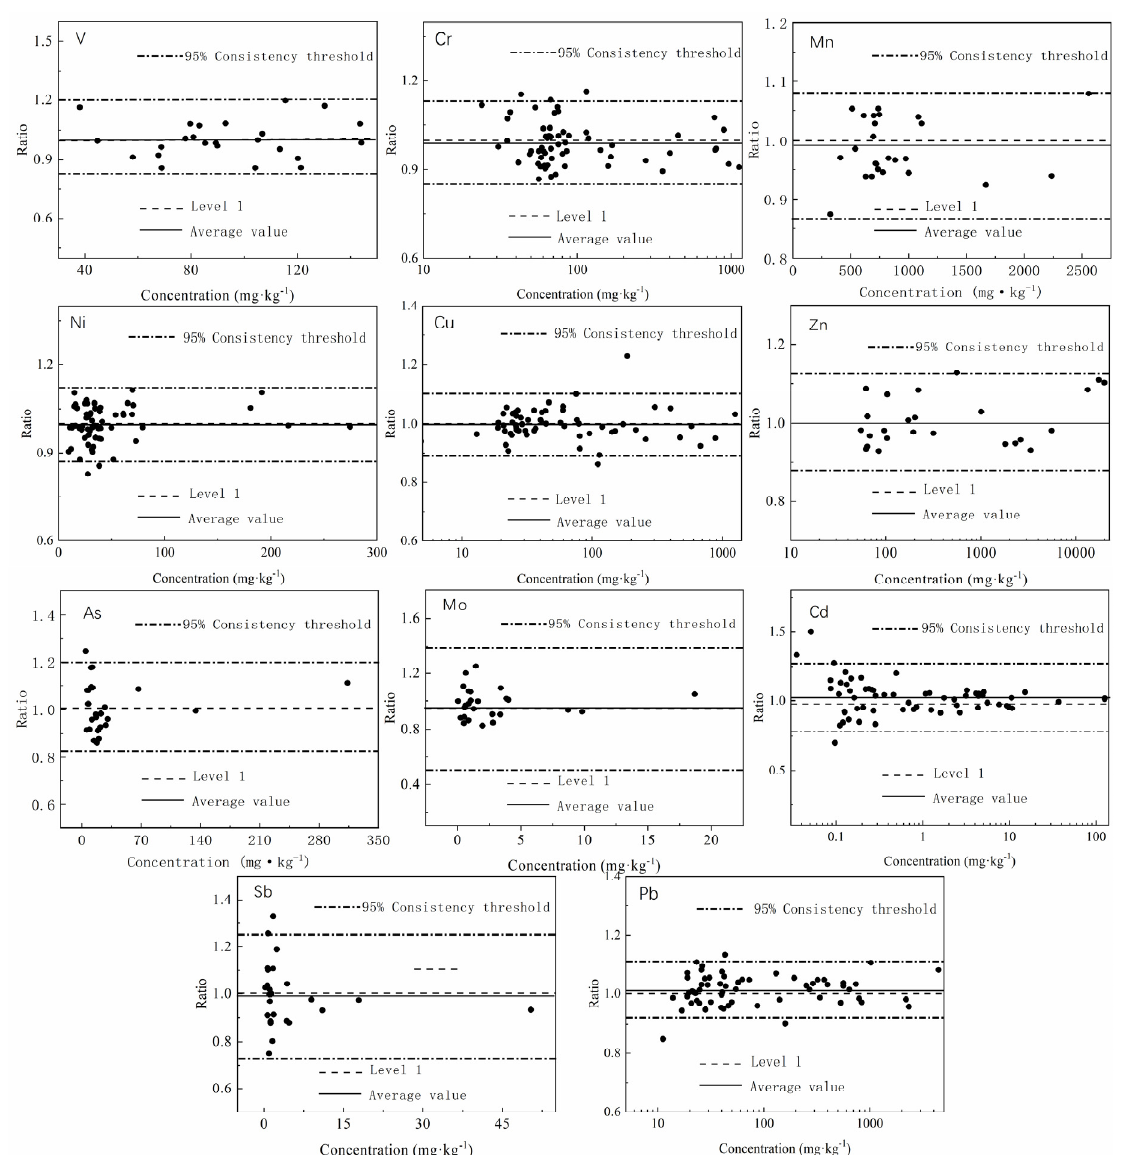
Figure 3. B-A diagrams of V, Cr, Mn, Ni, Cu, Zn, As, Mo, Cd, Sb and Pb. In Figure 3, the upper and lower boundary lines are both 95% limits of agreement, the middle solid line indicates the mean of the ratio series of the test results, and the horizontal dashed line indicates the ideal value of 1. The proximity of the mean line to the horizontal line 1 indicates the overall degree of consistency of the method. In Figure 3, the vast majority of the sample points are within the limits of agreement. Few sample points fall outside the boundary. The differences in the measurement results were within acceptable limits, and the two measurement methods were in good